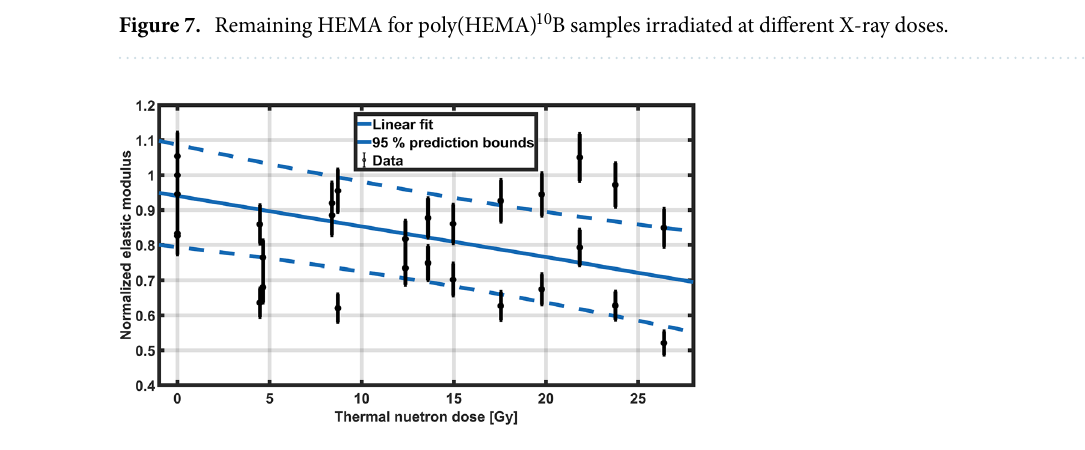
Figure 8. Relative elastic modulus for different contributions to the total absorbed dose due to neutron capture 10 in B